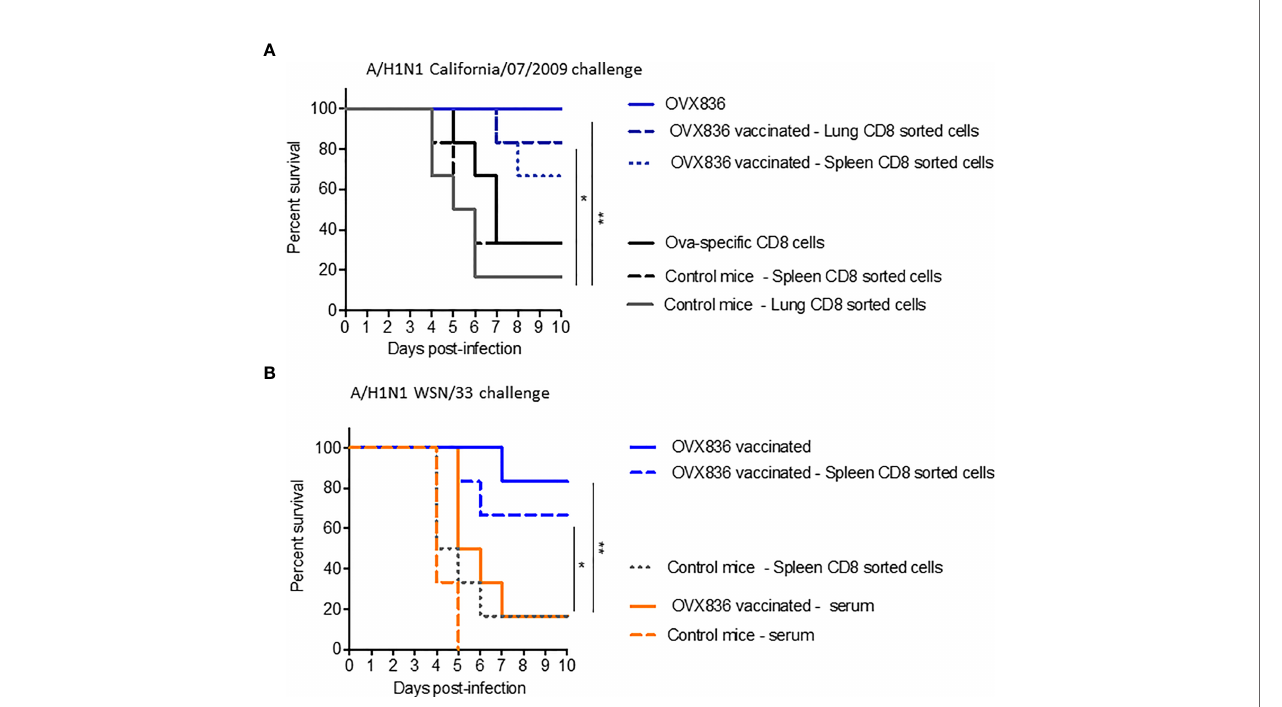
FIGURE 7 | NP-speci fi c CD8+ T-cells protect mice from lethal in fl uenza challenges. (A, B) Donor C57BL/6 mice (n = 6 – 7 in each group) received two IM immunizations (D0, D21) with OVX836 (30 m g), buffer (control mice), or OVA (10 m g) + IFA. Spleens and/or lungs were collected from the donor mice at D28 to obtain CD8+ T-cells for the transfer (A) . Lungs to obtain CD8+ T-cells and serum were collected from the donor mice at D36 for the transfer (B) . Naive C57BL/6 recipient mice (n = six in each group) received 5 × 10 5 lung-enriched CD8+ T-cells by the IV route or 300 m l of serum by the intraperitoneal (IP) route. Some 24 h after this adoptive transfer, all recipient mice were IN infected with 10 4.7 TCID 50 /20 µl of the in fl uenza viral strain H1N1 A/California/07/2009 (A) or H1N1 A/WSN/33 (B) . OVX836-vaccinated mice were used as positive controls in each experiment. Mice were then observed daily for clinical signs and body weight changes for 10 days. Percent survival rates are presented. *p < 0.05, **p < 0.01 by Log-Rank (Mantel – Cox)